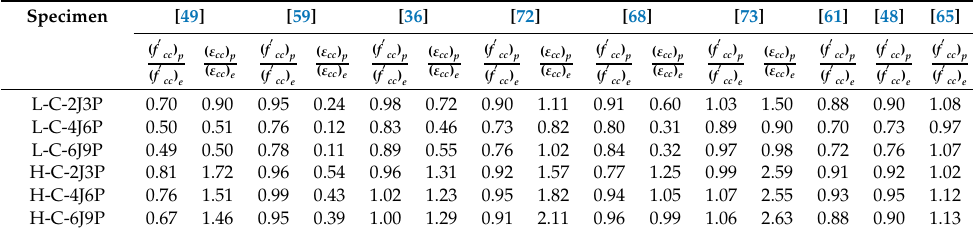
Table 10. Comparison of model predictions with experimental results of circular specimens. Specimen